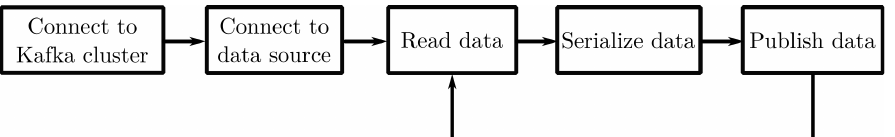
Figure 11. The Kafka data loggers share a similar workflow, yet differ in data sources. Each logger initializes a loop that continuously read, serialize, and publish data for data